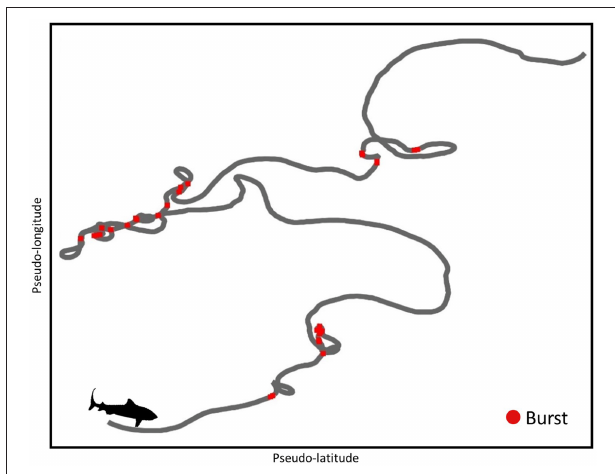
FIGURE 5 | Fifteen minute pseudo-track throughout a tortuous window in TS20. Track is colored by bursts (Overall Dyamic Body Acceleration > 0.2) and takes place at ∼ 21:30 in water ∼ 2m in depth. As constant speed was used to estimate pseudo-tracks, we caution that speed changes throughout these windows by tagged sharks may slightly influence the shape of resulting